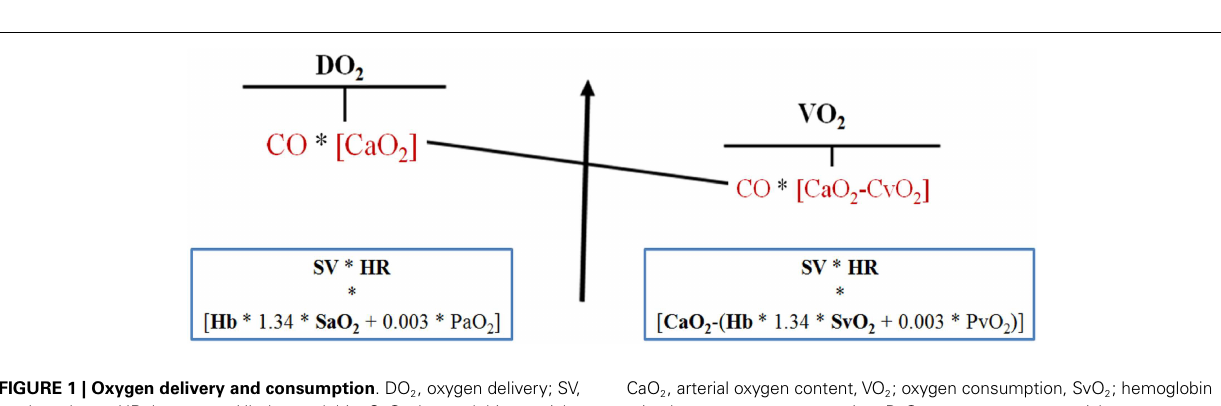
FIGURE 1 | Oxygen delivery and consumption . DO 2 , oxygen delivery; SV, stroke volume; HR, heart rate; Hb, hemoglobin; SaO 2 , hemoglobin arterial oxygen saturation; PaO 2 , arterial oxygen partial pressure; CO, cardiac output;